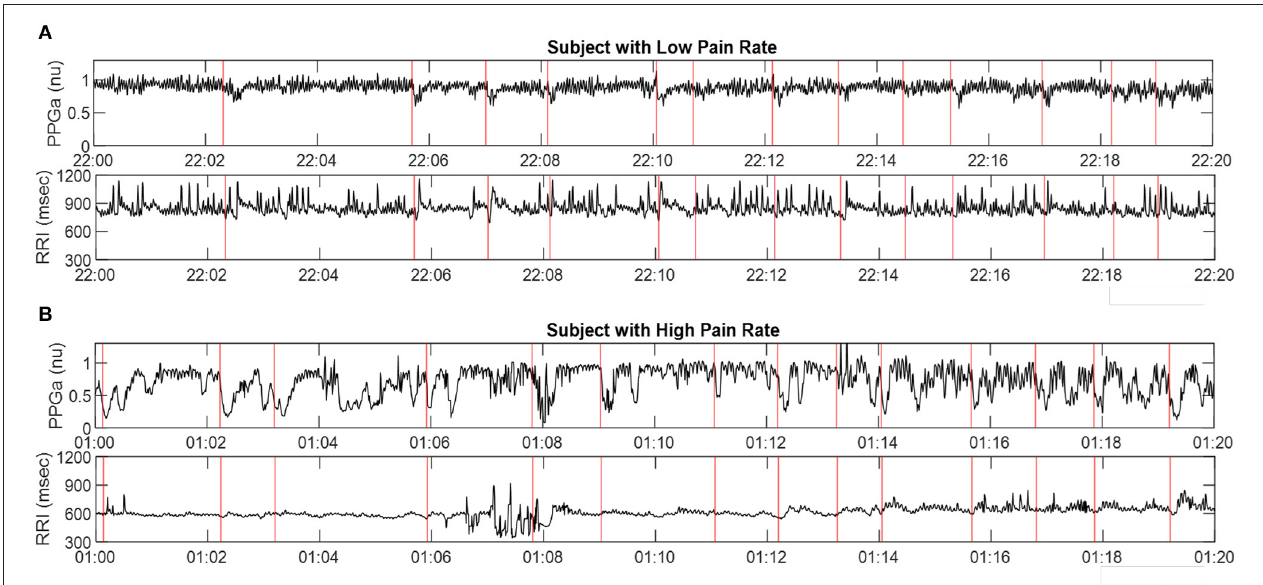
FIGURE 5 | Representative samples of PPGa and RRI time-series (20-min sections) derived from PSG data in two subjects: (A) in low pain category, and (B) in high pain category. Red vertical lines represent detected start-times of significant vasoconstrictions. The time-axes in A and B are displayed in military time format.